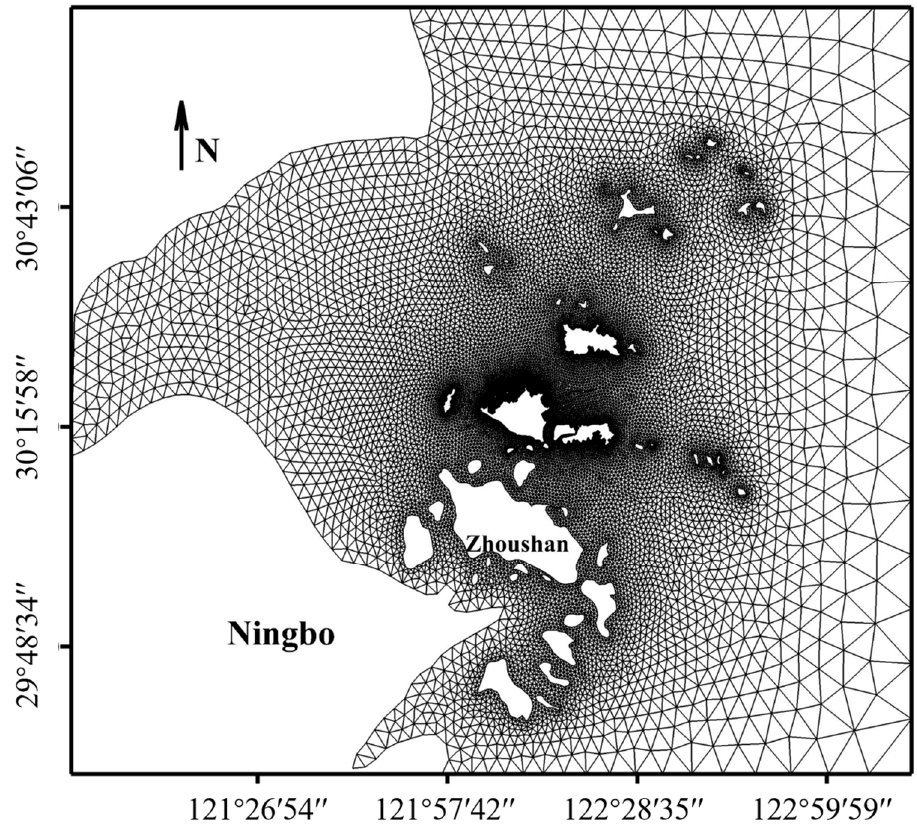
Figure 4. An unstructured, triangular mesh for the study area.